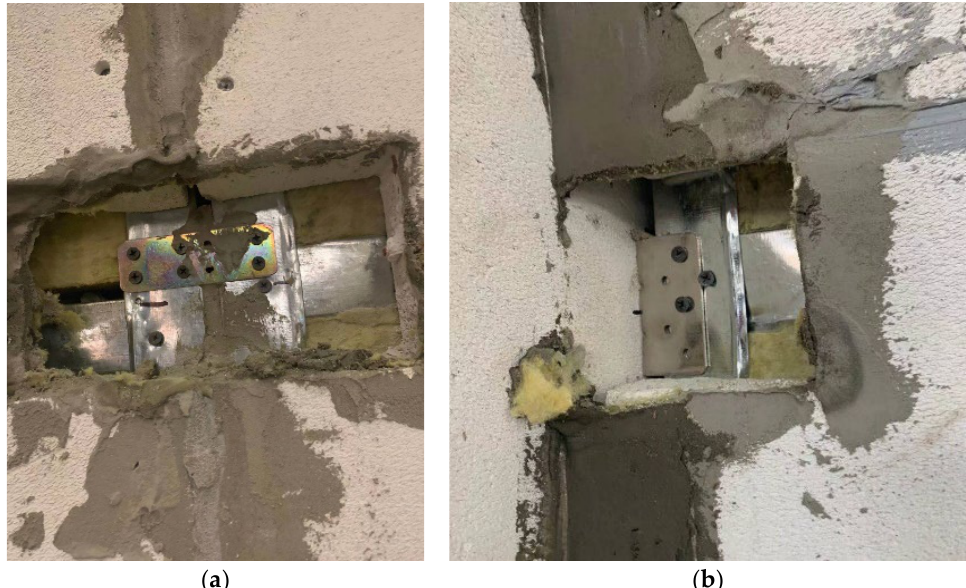
Figure 15. The panel connectors ( a ) and U-shaped connectors ( b ) after fire